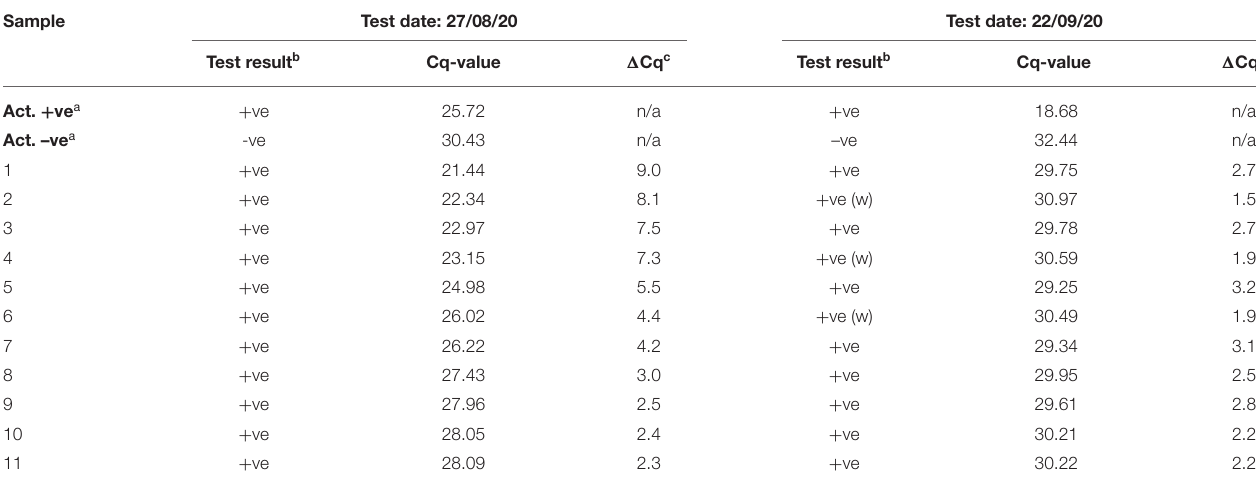
TABLE 2 | Comparison of Actiphage-test results after 1 month.